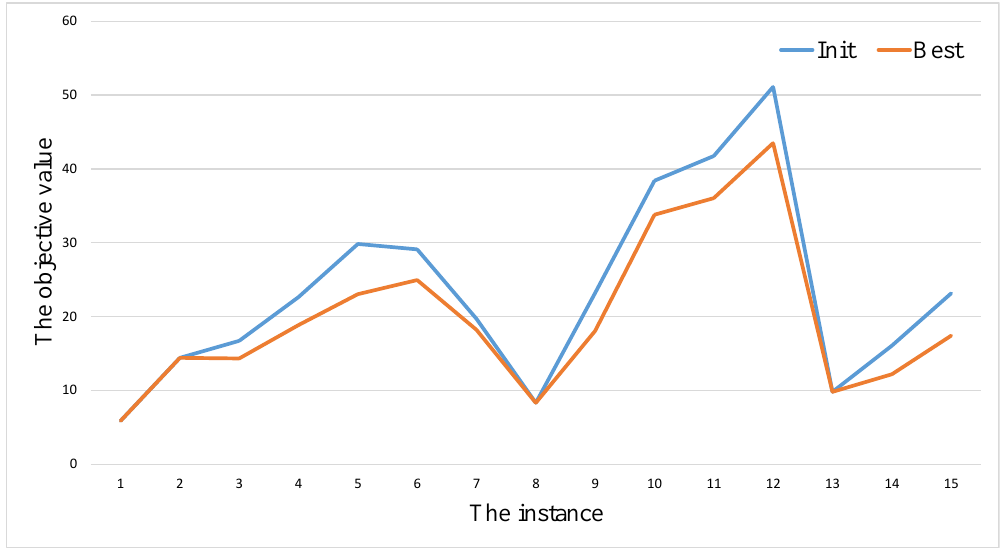
Figure 3. GAITLS performance analysis in Table 1.